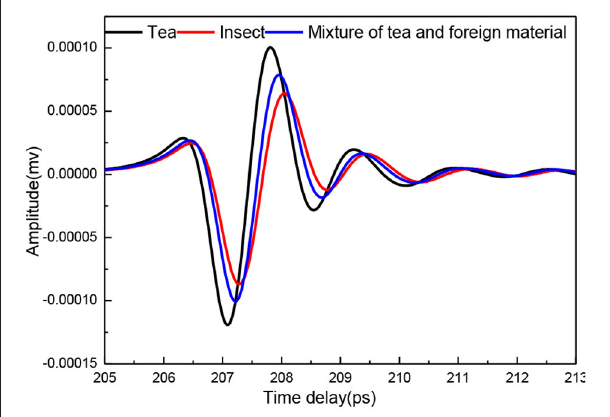
FIGURE 2 | THz time-domain spectra of tea, insect, and their mixture tablets.